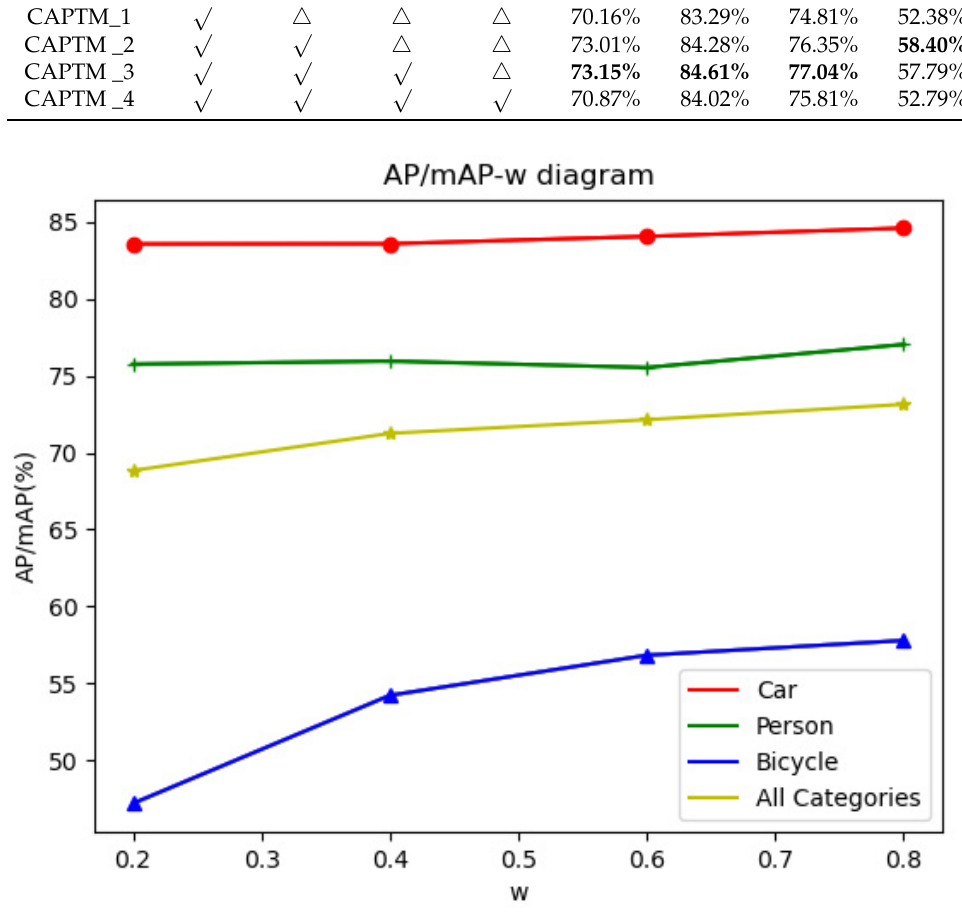
Figure 9. The AP/mAP-w diagram.